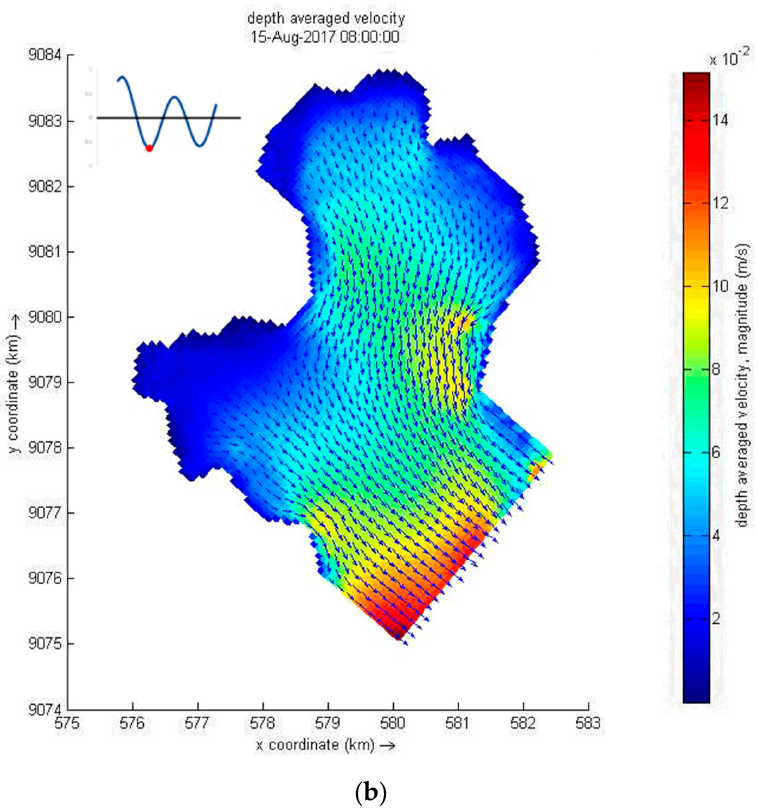
Figure 8. Current velocity model results ( a ) flood tide ( b ) ebb tide.